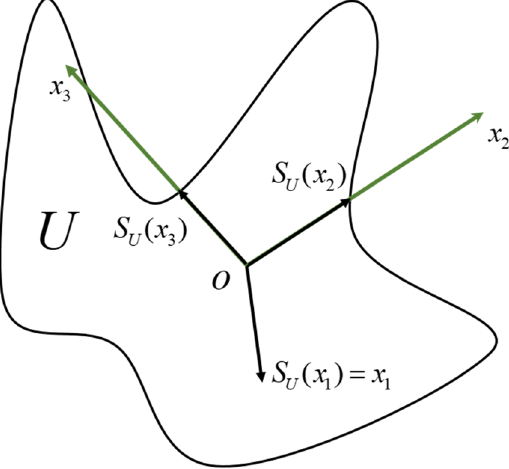
S x . Figure 1. Example of S ( x ) U i i U